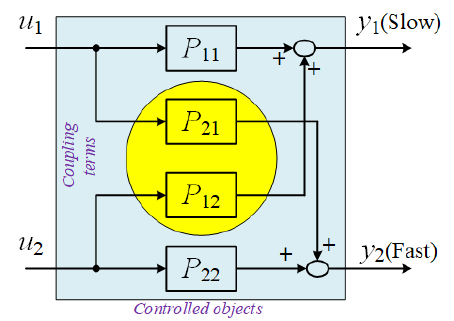
Figure 3. Block diagram of controlled objects.